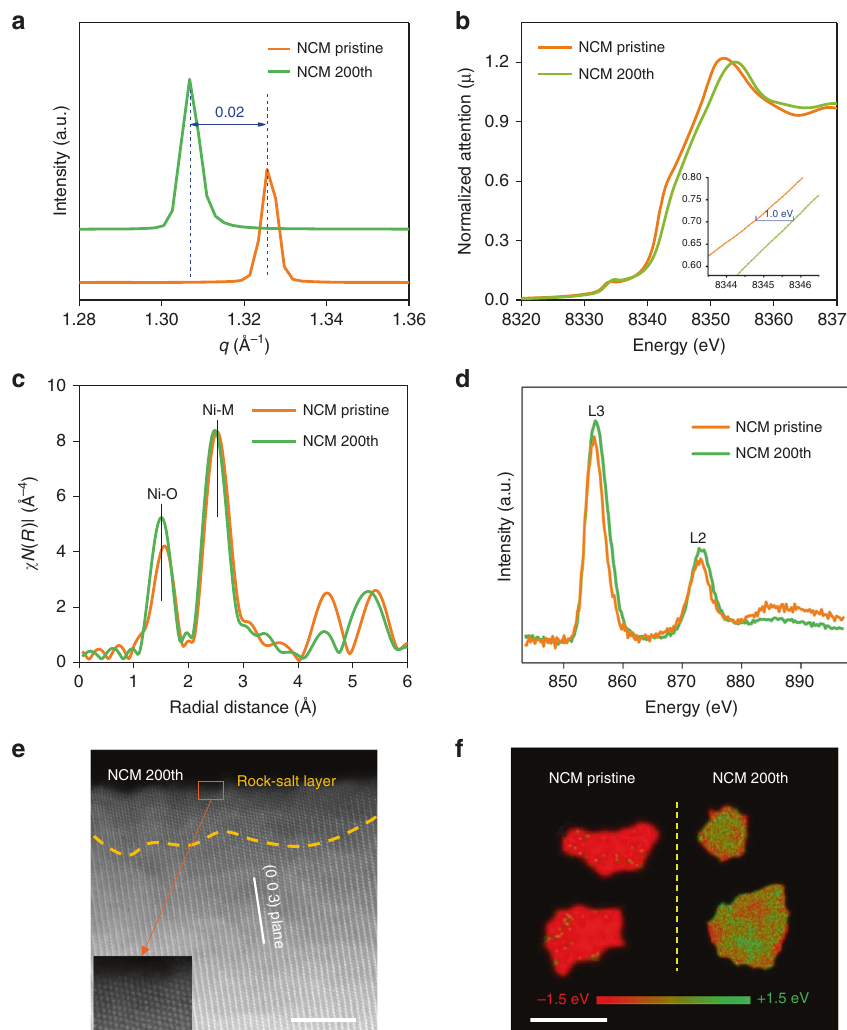
Fig. 3 Structural analysis of pristine and cycled NCM electrodes. a Synchrotron XRD pattern for NCM. b, c Ni K-edge XANES and EXAFS spectra of pristine and cycled NCM crystals. d Soft XAS spectra of Ni L-edge for pristine and 200th cycle NCM. e Atomic resolution HAADF-STEM images of 200 th cycled NCM samples. f Ex-situ 2D TXM of pristine and cycled NCM. Scale bars 2 μ